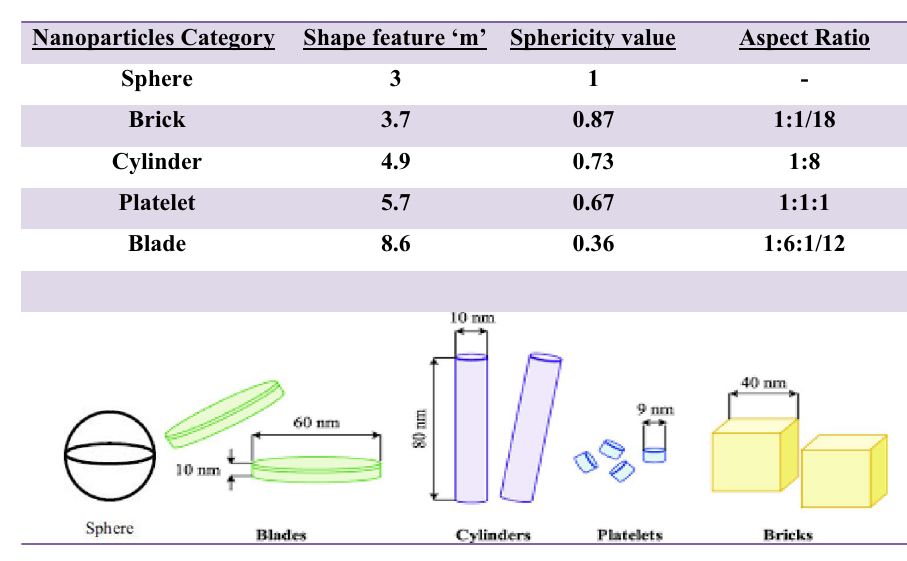
Table 2. Nanoparticle shape